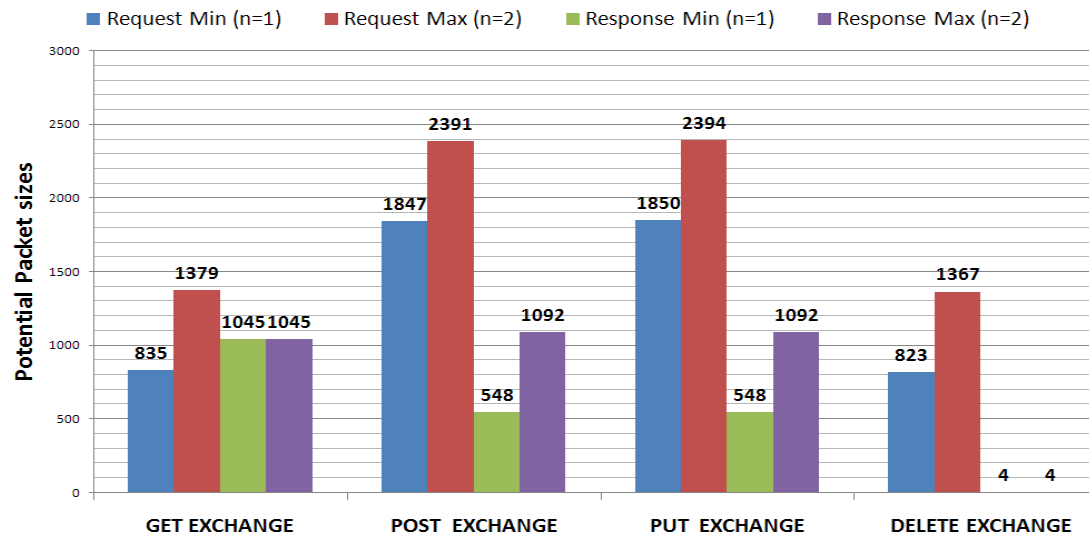
Figure 3. Potential Maximum CoAP Packet